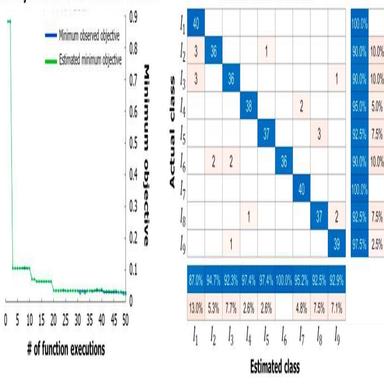
Performance evaluation results for the optimized CNN-based deep learning model for impact localization.